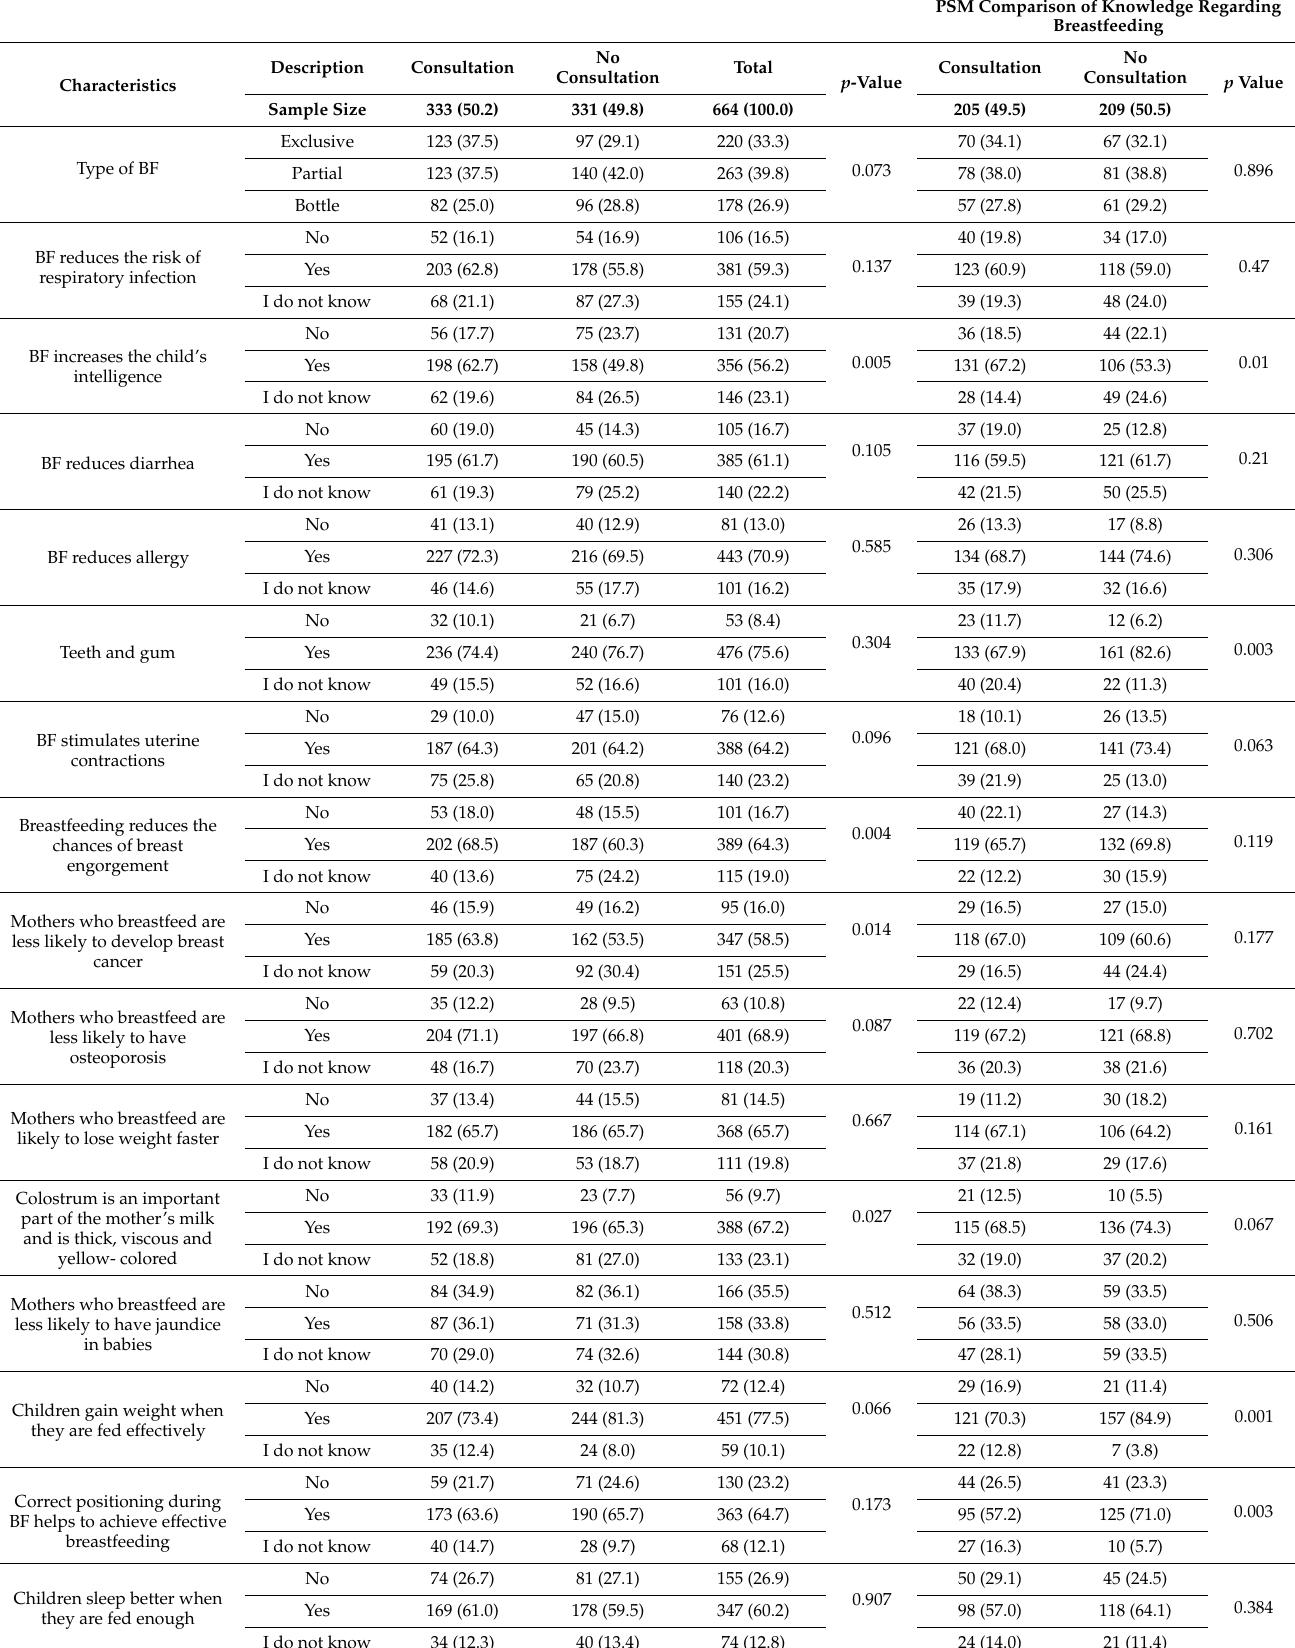
Table 3. Comparison of knowledge regarding breastfeeding between the two